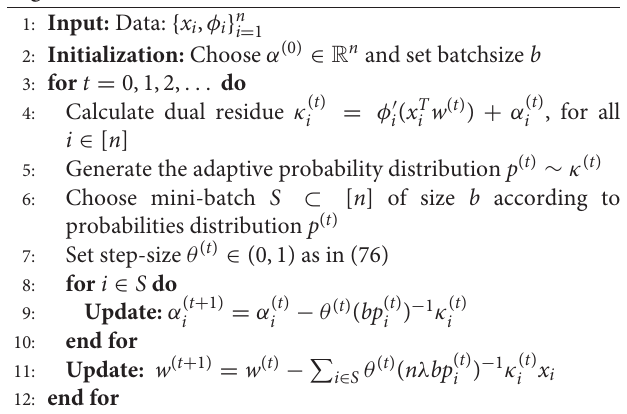
2 from n 4 coordinates. = =